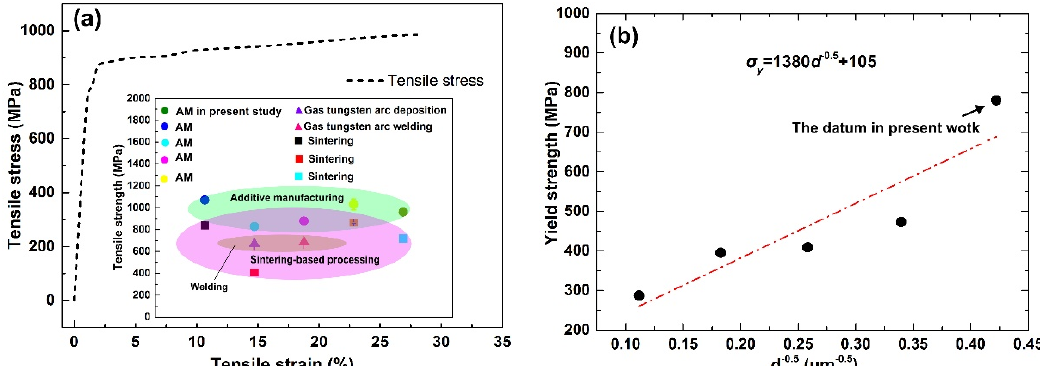
Figure 4. ( a ) Tensile stress-strain curve of Inconel 625 alloy and ( b ) yield strengths plotted versus d − 0.5 for Inconel 625 samples in the present work and literatures, the inset shows the comparison results of tensile strength for Inconel 625 samples in the present work and literatures.